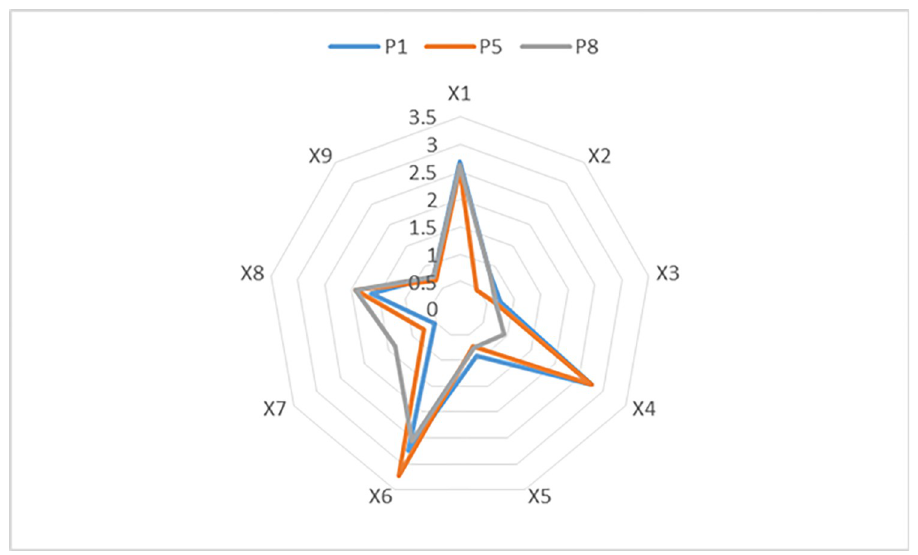
Fig 5. The radar maps of three COVID-19